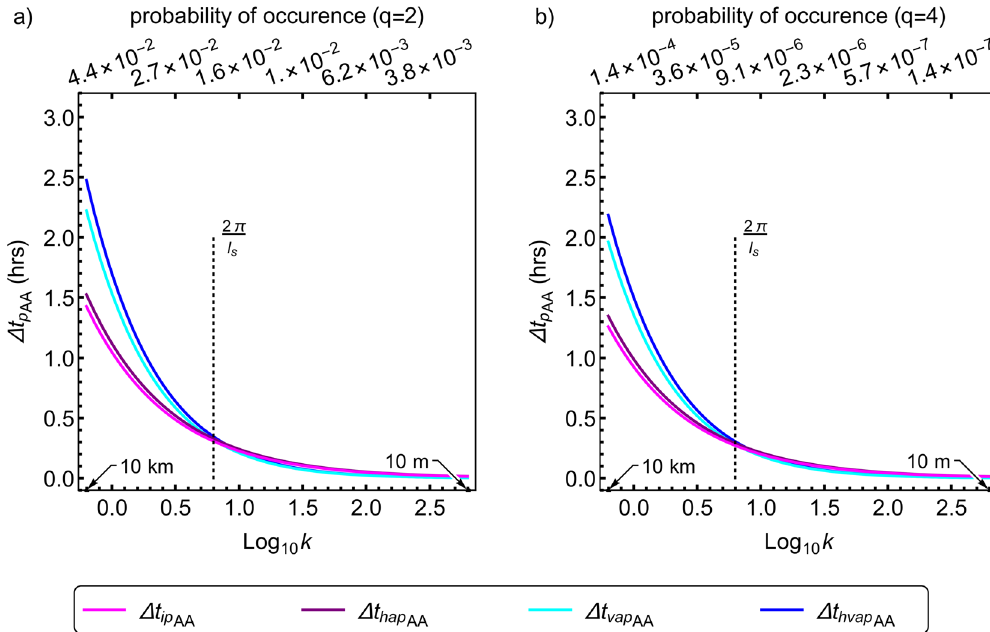
Figure 4. Angular averaged theoretical predictability limits of spatially isotropic and anisotropic (with 1000 m sphero-scale) horizontal wind fields. The wind field has multifractal parameters α = . = . = . C H 1 5, 0 15, 0 33, 1 and anisotropy parameters, as discussed in the text. The subscripts ip , hap , vap , hvap denote isotropic, horizontally anisotropic, vertically anisotropic, horizontally and vertically anisotropic cases, whereas the subscript AA indicates angular averaging. While the angular averaged predictability limits is in hours, the wavenumber k is in km − 1 and corresponds to scales ranging from 10 m to 10 km. The two panels differ only by the order of autocorrelation q used in deriving the predictability limits. ( a ) spectra based angular averaged predictability limits ( q = 2) as a function of logarithmic wavenumber. The probability of occurrence shows the probability distribution of energy fluxes above the scaling threshold ( λ γ q , where Largest scale 10,000 km 10,000 km is the scale ratio, l ranges from 0.01 km to 10 km, and γ λ = = = q is the order Δ r l Intermediate scale of singularity corresponding to the order of moment q ) given by ε q (where c ( γ ) is the codimension of the order of singularities and is related to K ( q ) as shown in Sect 4.3), corresponding to 2 ( l ranges from 0.01 km to wavenumbers 10 0 ,10 0.5 ,10 1.0 ,10 1.5 ,10 2.0 ,10 2.5 (see text). The wavenumber = = π k k l 1 ∝ k l s ) and that larger events are more probable and predictable, whereas comparison between these two figures indicates that more extreme events (less probable) are less predictable. Comparing Fig. 3 with this figure shows that fields with smaller sphero-scales are more